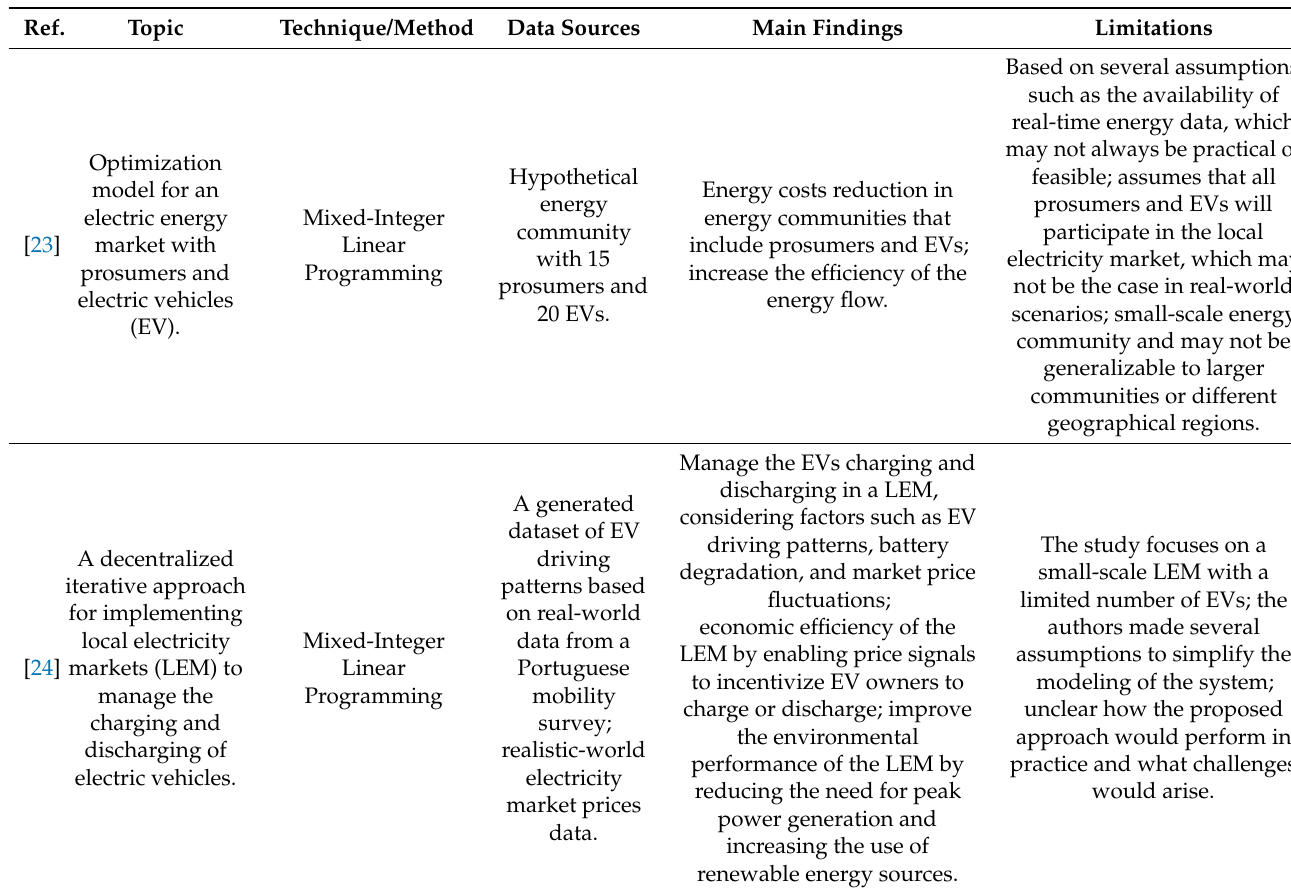
Table 1. Summary of related